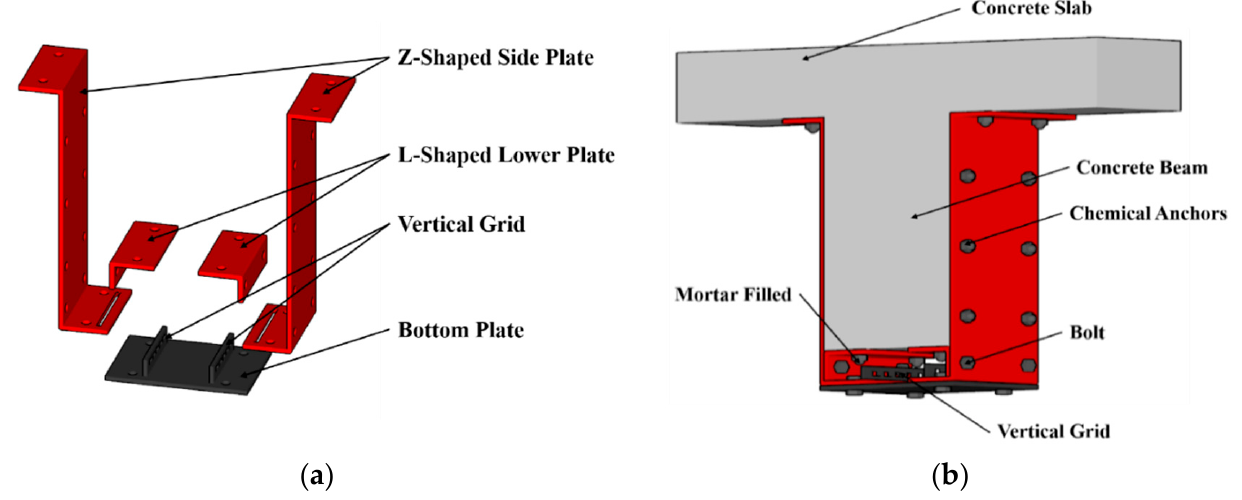
Figure 1. Proposed retrofitting system: ( a ) The components of proposed retrofitting system; ( b ) The retrofitted beam with the proposed system.